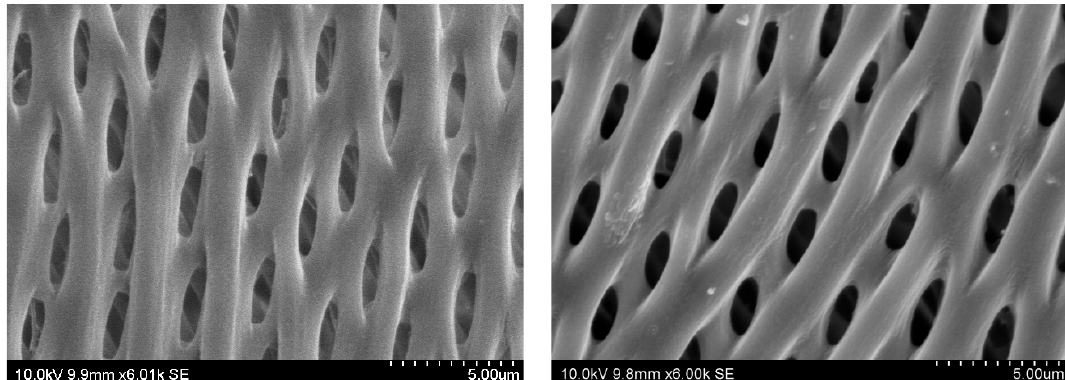
Figure 7. Surface micrographs of dyed wood before and after UV radiation.